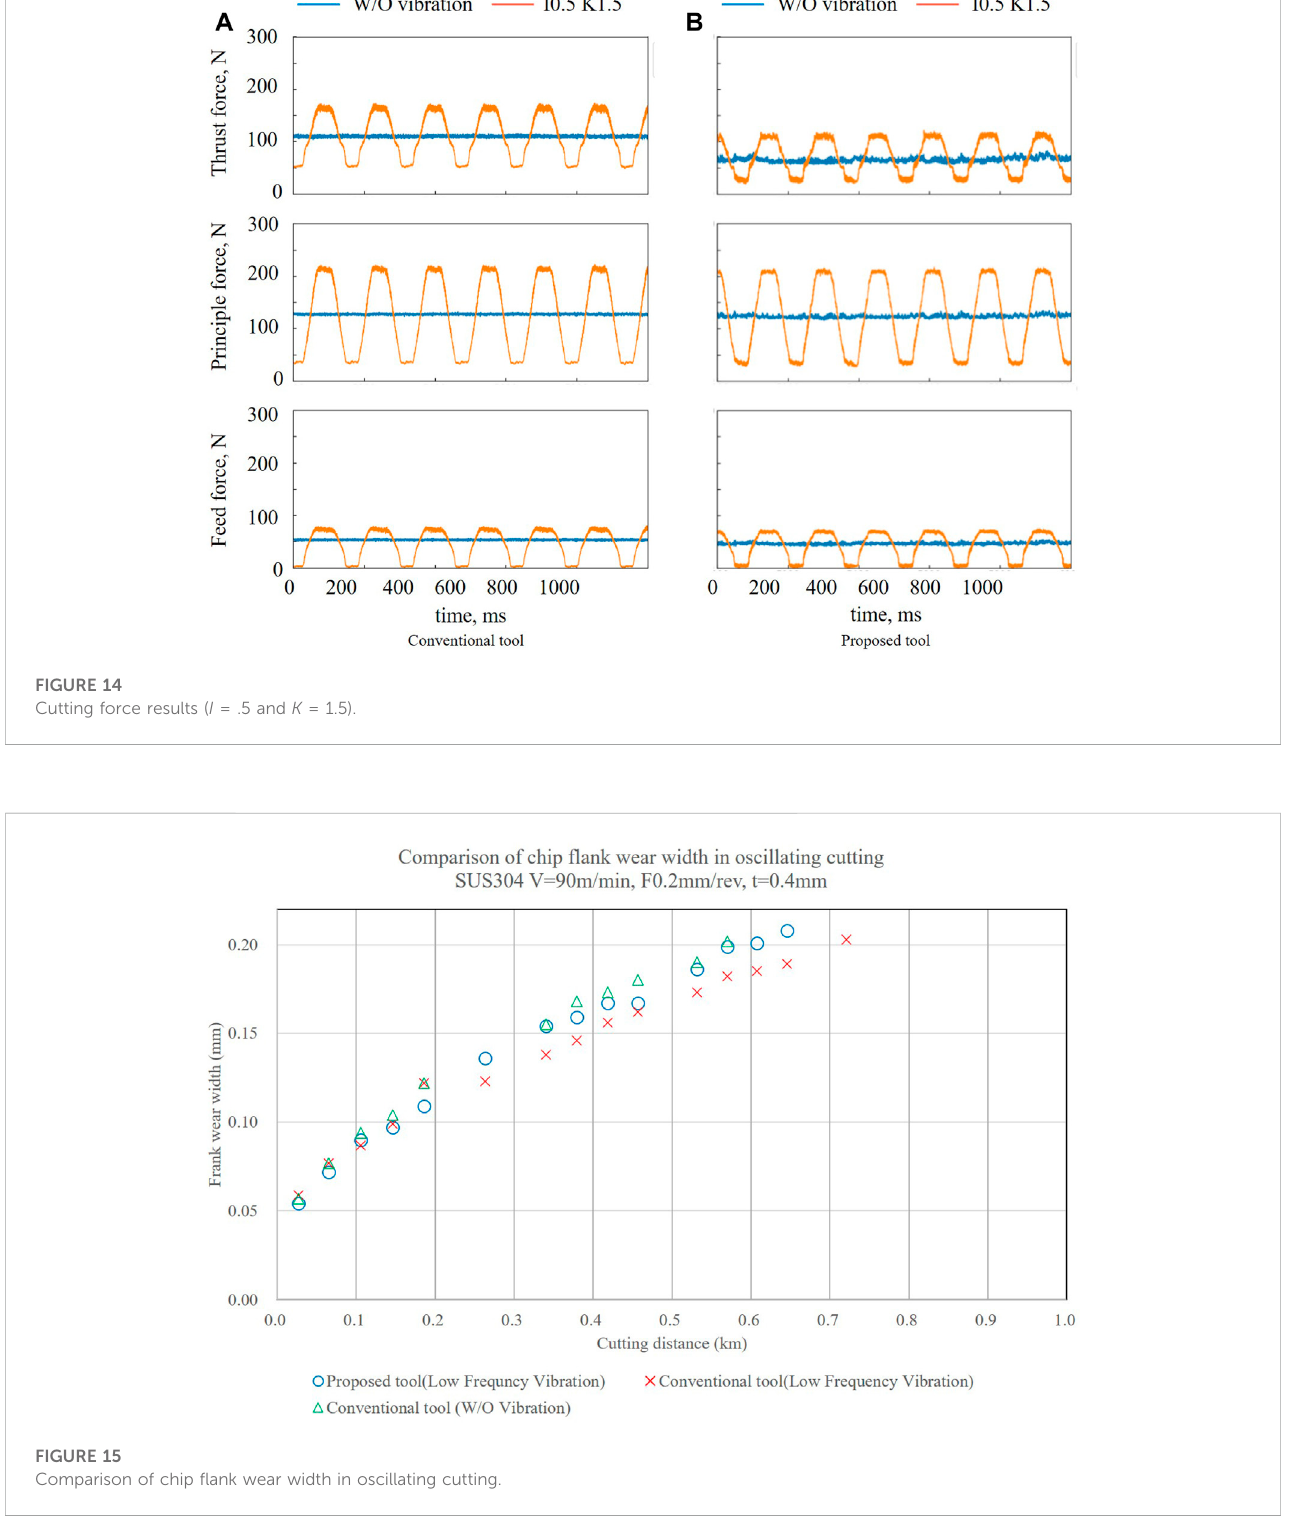
cutting-edge paths increased in size. There were several differences between the values measured in the simulation and those obtained from actual machining using the proposed tool. Depending on the cutting conditions, the chip form become tear type, and the machine surface get